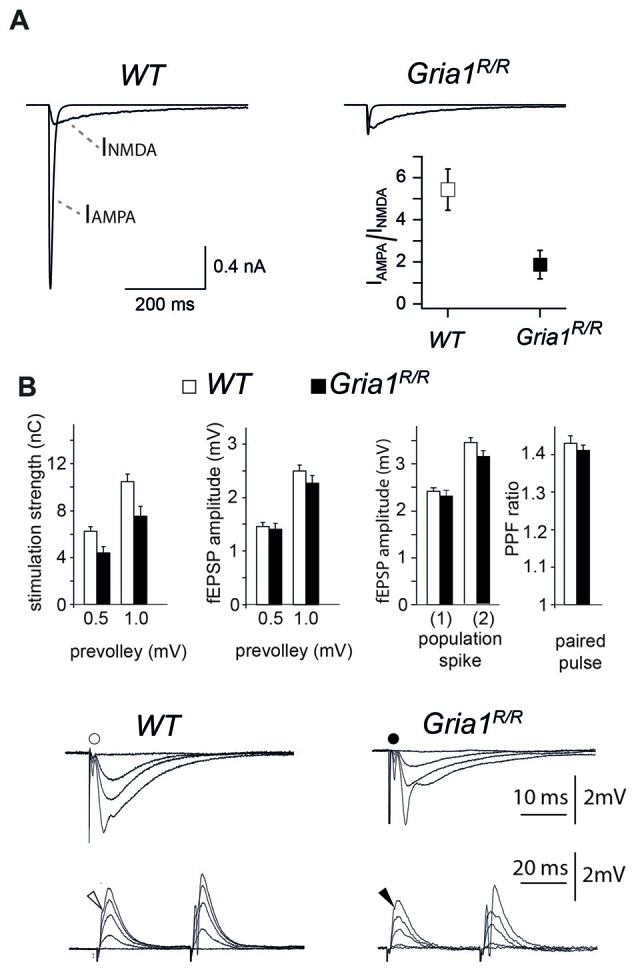
Whole-soma currents, excitatory synaptic transmission, synaptic excitability and paired-pulse facilitation in the CA1 hippocampal region. (A) Recordings of glutamate activated AMPAR and N-methyl-D-aspartate receptor (NMDAR) currents from nucleated patches of CA1 pyramidal cells obtained from P42 WT (left) and Gria1R/R (right) mice. IAMPAR/NMDAR ratio is significantly different at P42; IAMPAR/NMDAR ratio 1.87 ± 0.68 in Gria1R/R, n = 7 from 3 mice; 5.43 ± 0.97 in WT, n = 9 from 4 mice; p < 0.01. (B) Left: stimulation strengths (in nC) necessary to elicit a prevolley of a given amplitude (0.5 mV, 1.0 mV and 1.5 mV) in slices from WT (open columns) and Gria1R/R (filled columns) mice. Middle left: fEPSP amplitudes in the two genotypes as a function of the three prevolley amplitudes. Middle right: (1) the fEPSP amplitudes in slices from the two genotypes necessary to elicit a just detectable population spike; and (2) a population spike of 2 mV amplitude. Right: paired-pulse facilitation (PPF) ratio in the two genotypes at an inter-stimulus interval of 50 ms. Lower panels: each trace is the mean of five consecutive synaptic responses in str. radiatum elicited by different stimulation strengths in slices from WT (left) and Gria1R/R (right) mice. The prevolleys preceding the fEPSPs are indicated by circles. The lower recordings show traces from str. pyramidale elicited by paired-pulse stimulation (50 ms interstimulus interval). Arrowheads indicate the population spike threshold. The number of experiments ranged from 30 to 82. Data are shown as mean + SEM.